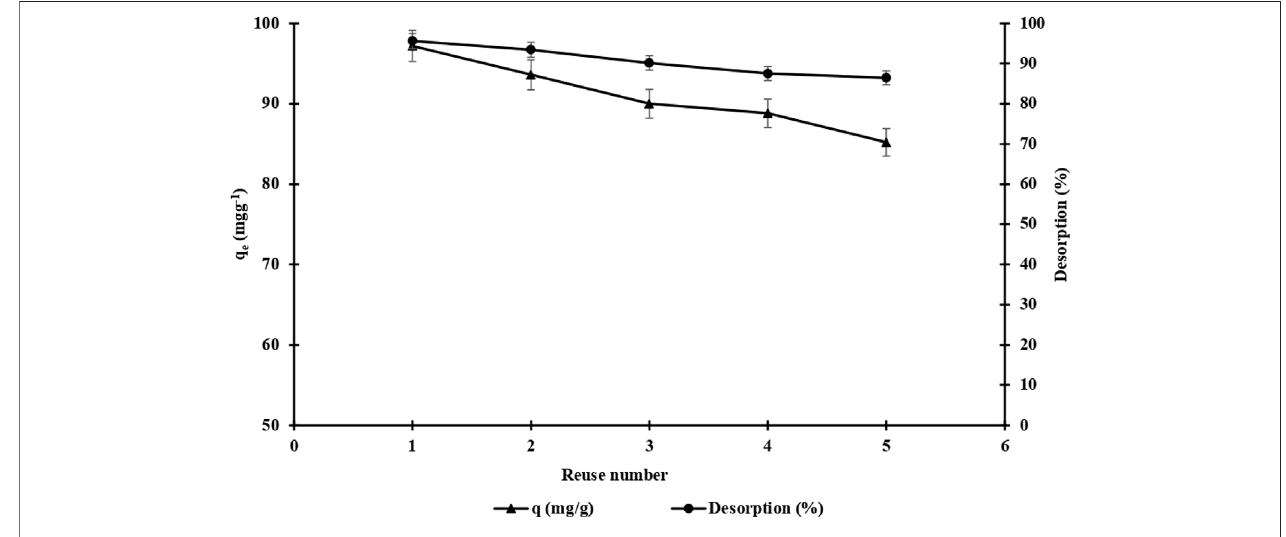
FIGURE 9 | Reusability of m-DE-APTES.